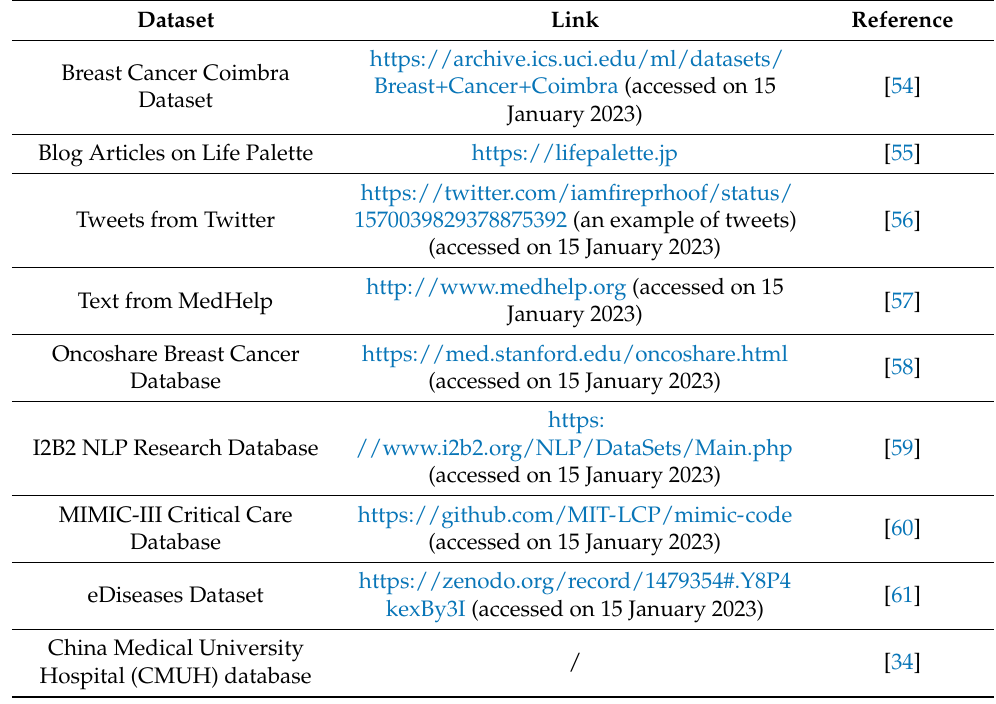
Table 9. The links to publicly available